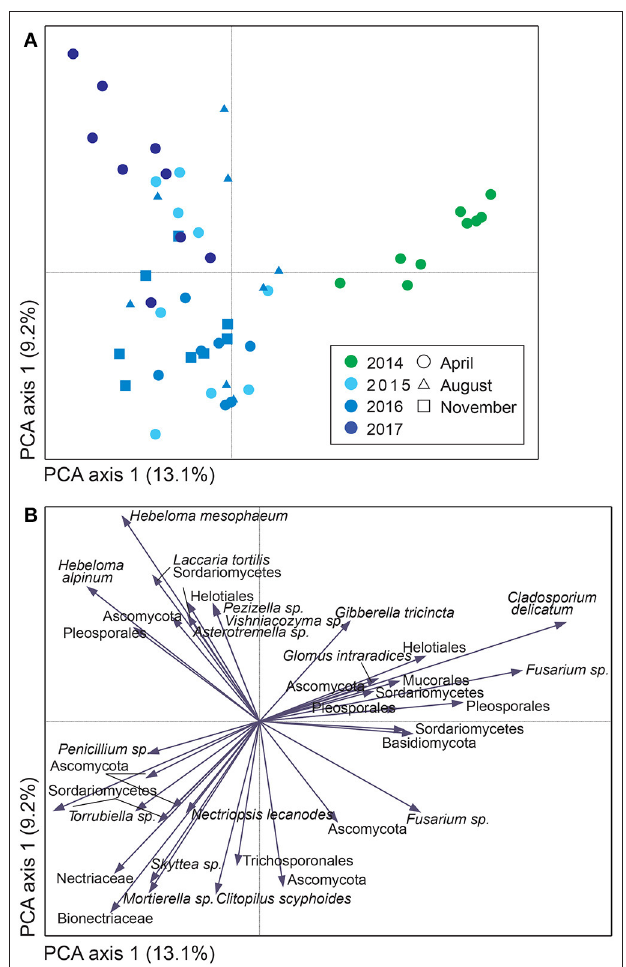
FIGURE 6 | Variation in soil fungal community composition in Salix genotype trial with two genotypes (“Loden” and “Tora”) planted in monocultures and 2-mixture in Rostock, Germany, visualized by (A) a sample plot and (B) a sample plot of a principle component analysis (PCA) and based on PacBio sequencing of amplified ITS2 markers. The PCA was based on 217 identified fungal SHs, rarefied data. Symbols in (A) are color coded according to year, with symbol shape, indicating sampling month and area, indicating total number of SHs in each sample. Axes 1 and 2 explained 13.1 and 9.2%, respectively, of a total inertia of